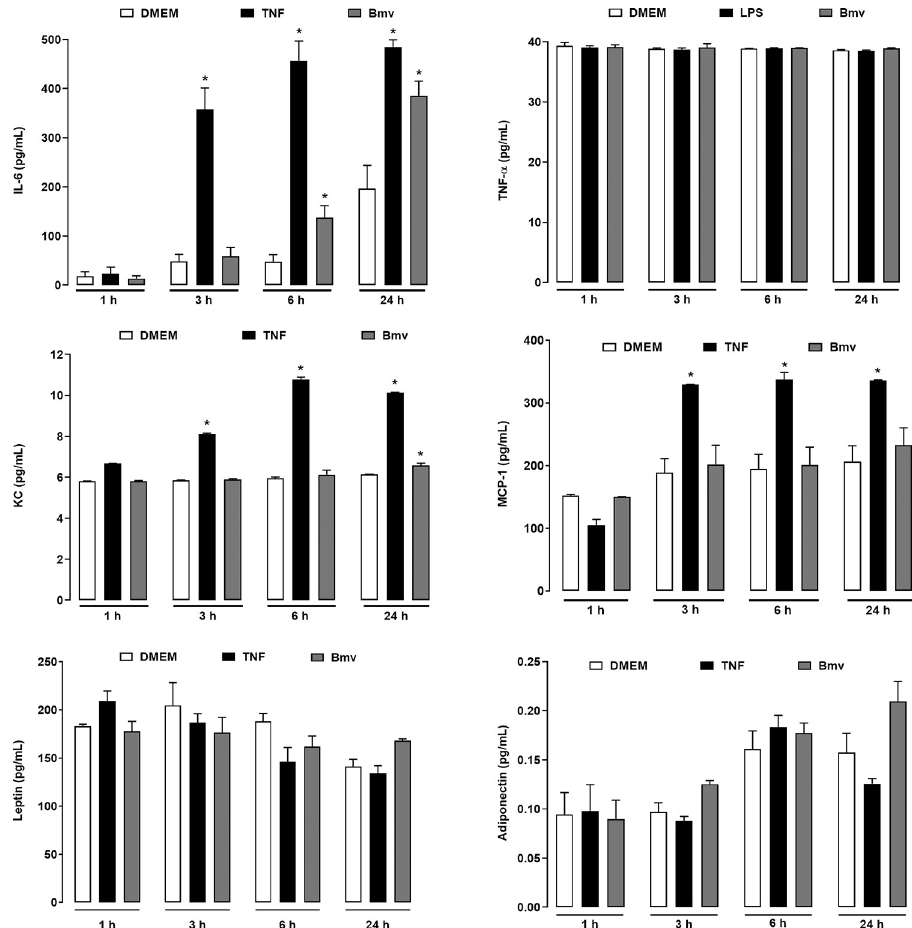
Fig 9. Bmv stimulates the release of IL-6 and KC/IL-8 but not TNF- α , MCP-1, leptin nor adiponectin by preadipocytes. 3T3-L1 preadipocytes (2 x 10 5 cells/well) were incubated with Bmv (1 μ g/mL), or TNF- α , 20 ng/mL (positive control) or LPS, 1 μ g/mL (positive control), or DMEM (control) for the above indicated time intervals. Concentration of cytokines and adipokines in culture supernatants was evaluated by EIA. Results are expressed as mean + S.E.M. of 3 independent assays (n = 4). � p < 0.05 vs control (ANOVA and Bonferroni post